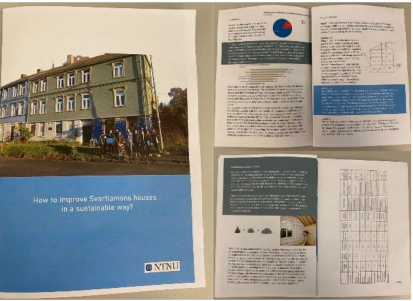
Figure 23. Practical guide developed by NTNU Students for Svartlamon